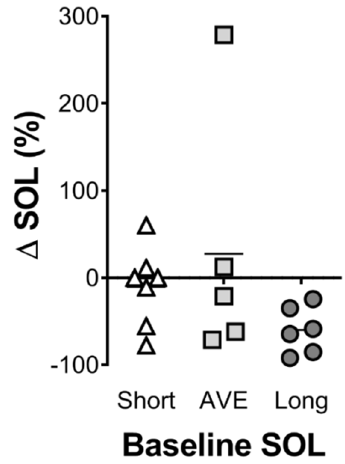
Figure 3. Individual data points for ( A ) total sleep time (TST), ( B ) wake after sleep onset (WASO), ( C ) sleep efficiency (SE), and ( D ) sleep onset latency (SOL). Bars and error bars are means and SD, respectively. Each point represents an individual.